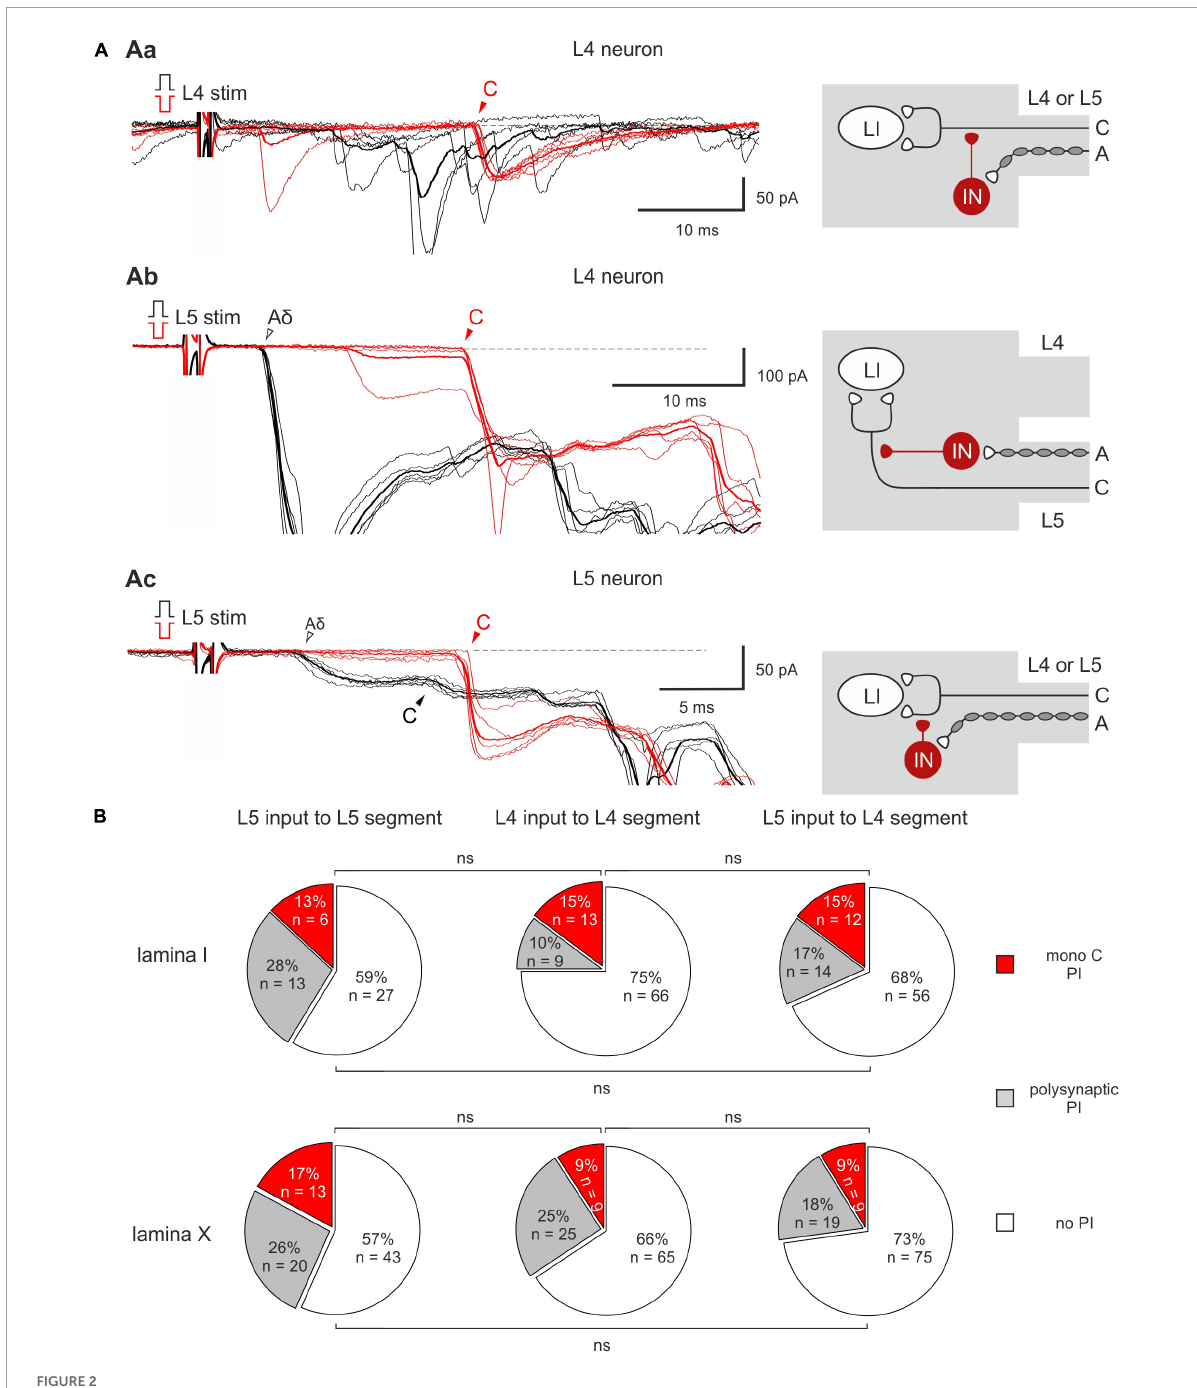
FIGURE2 Homosegmental A β / δ -AD-PI of C-fiber inputs. (Aa,b) Left: complete inhibition of monosynaptic C-fiber inputs. The neuron was located in the segment of the primary afferent entrance (Aa) and in the adjacent rostral segment (Ab) . Right: putative schematics. (Ac) Left: partial suppression of a monosynaptic C-fiber input. Right: putative schematics. Individual (five traces) and averaged (bold) excitatory postsynaptic currents (EPSCs) evoked in spinal neurons by dorsal root stimulation by normal (black) and inverted (red) pulses. Normal pulse (+150 µ A × 1 ms) was used to activate all primary afferents, while the pulse of inverted polarity (–150 µ A × 1 ms) was applied to induce an anodal block of A β / δ -fibers and selectively activate C-fibers. The anodal block of A β / δ -fibers resulted in the disappearance of the monosynaptic A δ -fiber-mediated EPSC (open arrowheads) but either in an appearance of a new monosynaptic C-fiber-mediated EPSC (Aa,b) or in an increase in the amplitude of already existing EPSC ( Ac , note a 2-3 ms increase in the latency of the EPSC evoked by inverted pulse stimulation) which were relieved from AD-PI (filled arrowheads). IN, inhibitory interneuron; LI, lamina I neuron. Putative schemes are valid for both lamina I and X neurons. (B) Proportion of lamina I (top row) and lamina X (bottom row) neurons showing C-fiber input disinhibition after anodal block of A β / δ -fibers. ns, no significant difference (Fisher’s exact